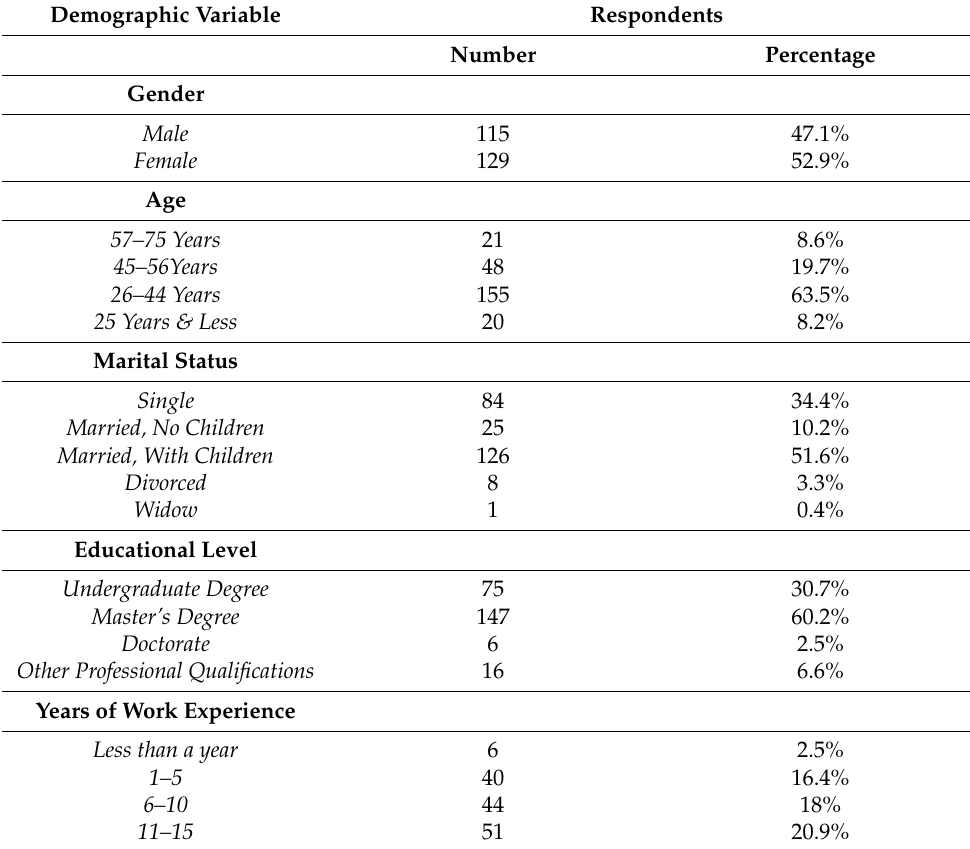
Table 1. Summary of Respondents Demographics, n = 244.